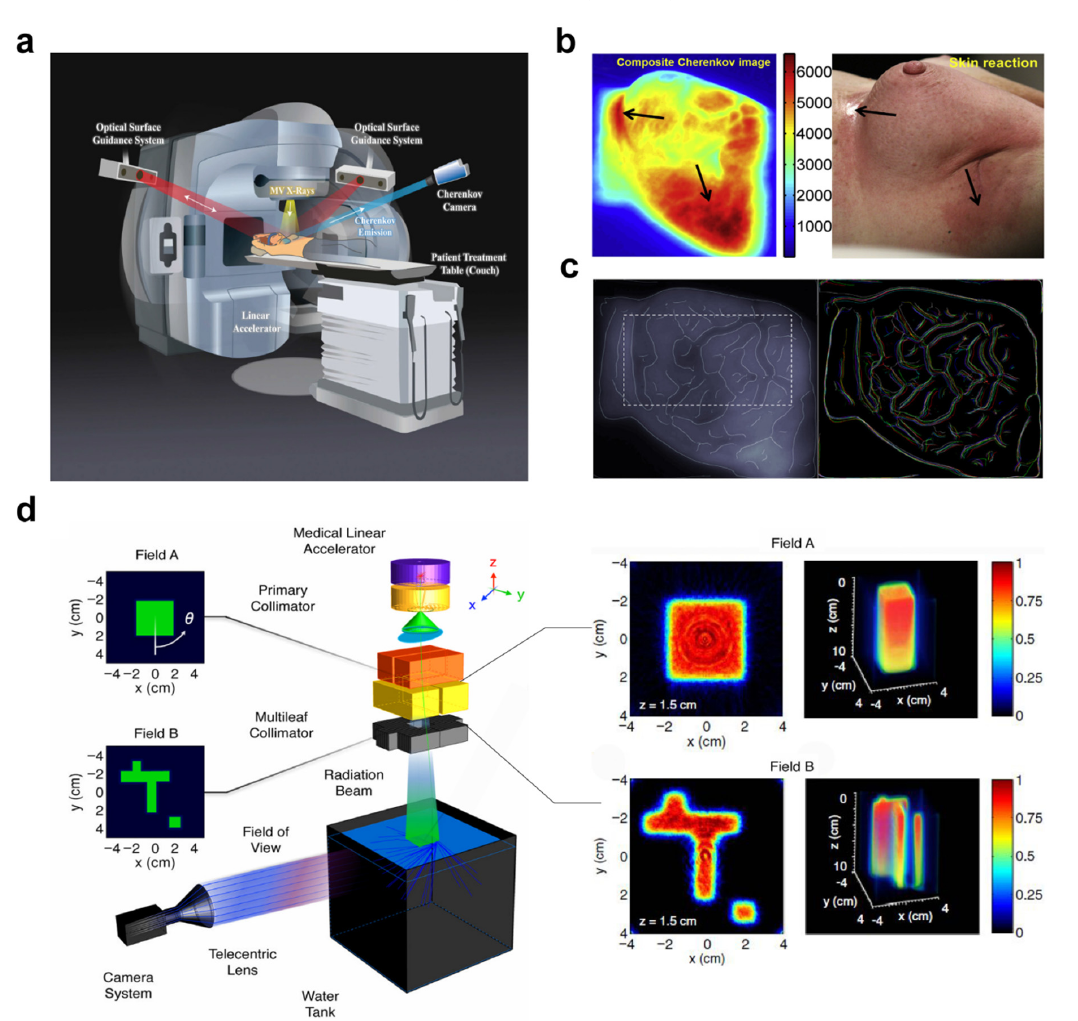
Figure 4. Schematic diagram of Cherenkov luminescence (CL) used in radiotherapy. ( a ) The patient setup during radiotherapy. The Cherenkov camera is synced to the pulses of the medical linear accelerator to remove ambient light. Adapted with permission from Ref. [38] 2020 Springer Nature. ( b ) Left: CL examined for imaging superficial doses. Right: Skin reaction of the treatment region at the end of radiation. High superficial doses in areas typical for higher-grade radiation skin reactions. Arrow pointing to inframammary fold indicates skin desquamation. Adapted with permission from Ref. [122] 2014 Elsevier. ( c ) Left: The beam edge enhanced CL image with a chosen internal region (indicated by dotted lines) within the treatment beam field. Right: Detected edges in CL images for patient, false colored for different imaged treatment fractions. Adapted with permission from Ref. [44] 2015 IPO Publishing. Ltd. ( d ) Left: Experimental schematic of a Cherenkov dosimetry imaging system. Right: The reconstructed cross section. Adapted with permission from Ref. [46] 2013 Optica Publishing Group.